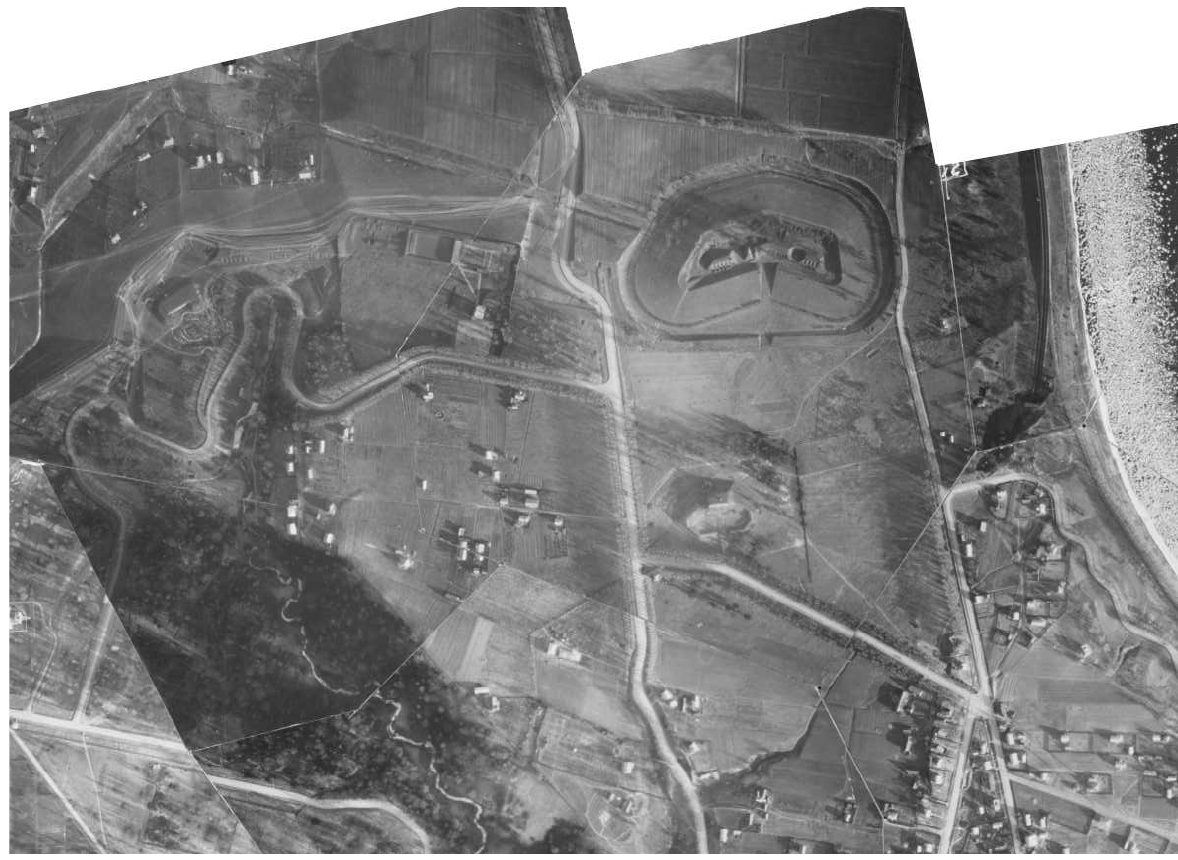
Fig 7. Fragment of central fortification on the right bank of the Nemunas river – redoubt and powder warehouse around 1930 (Kaunas County Archives, Fund 218, Inventory